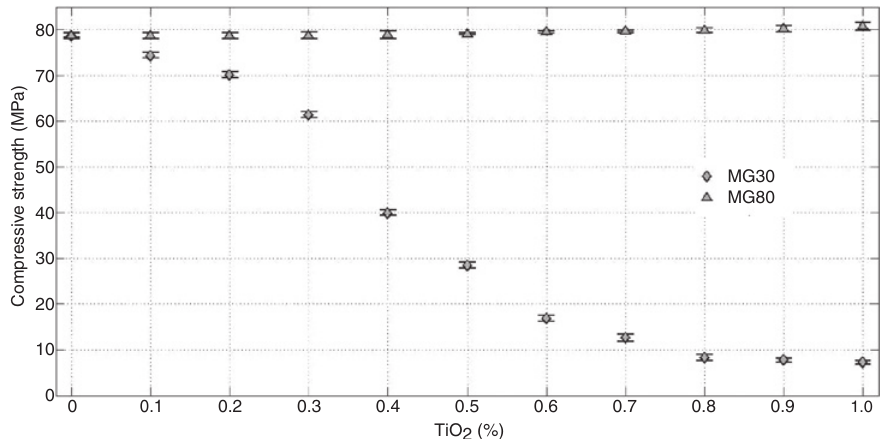
/MG30 and TiO Figure 19: TiO 2